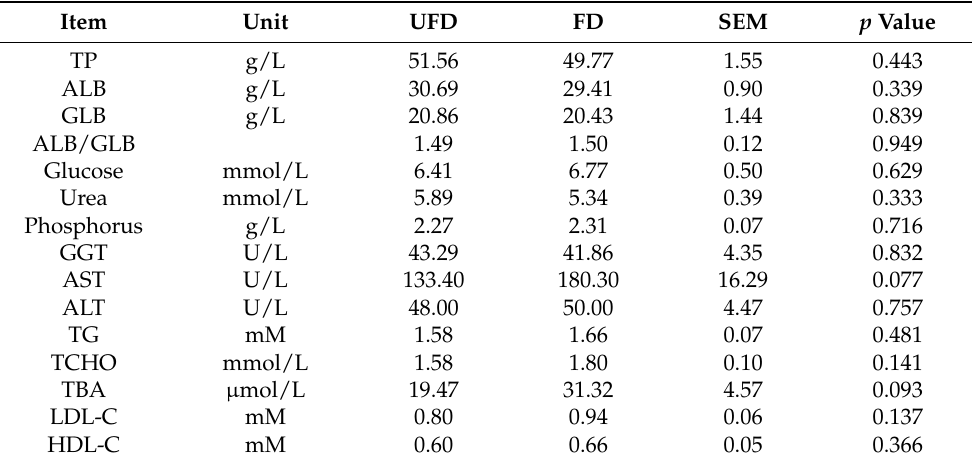
Table 5. Effects of dietary supplementation with FFS on the serum biochemical parameters